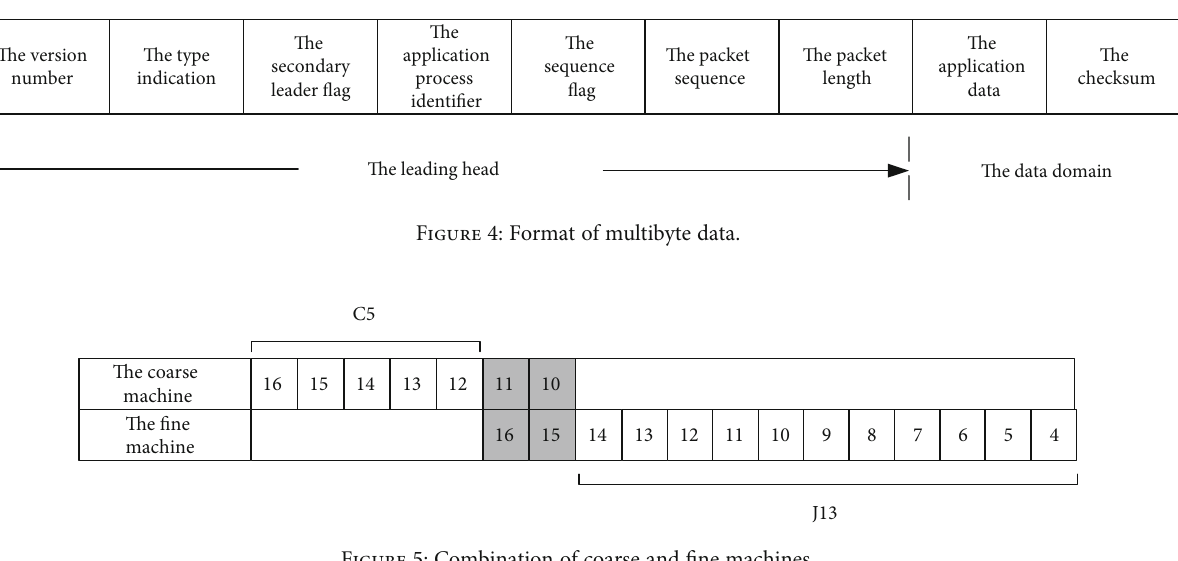
Figure 5: Combination of coarse and fi ne machines.